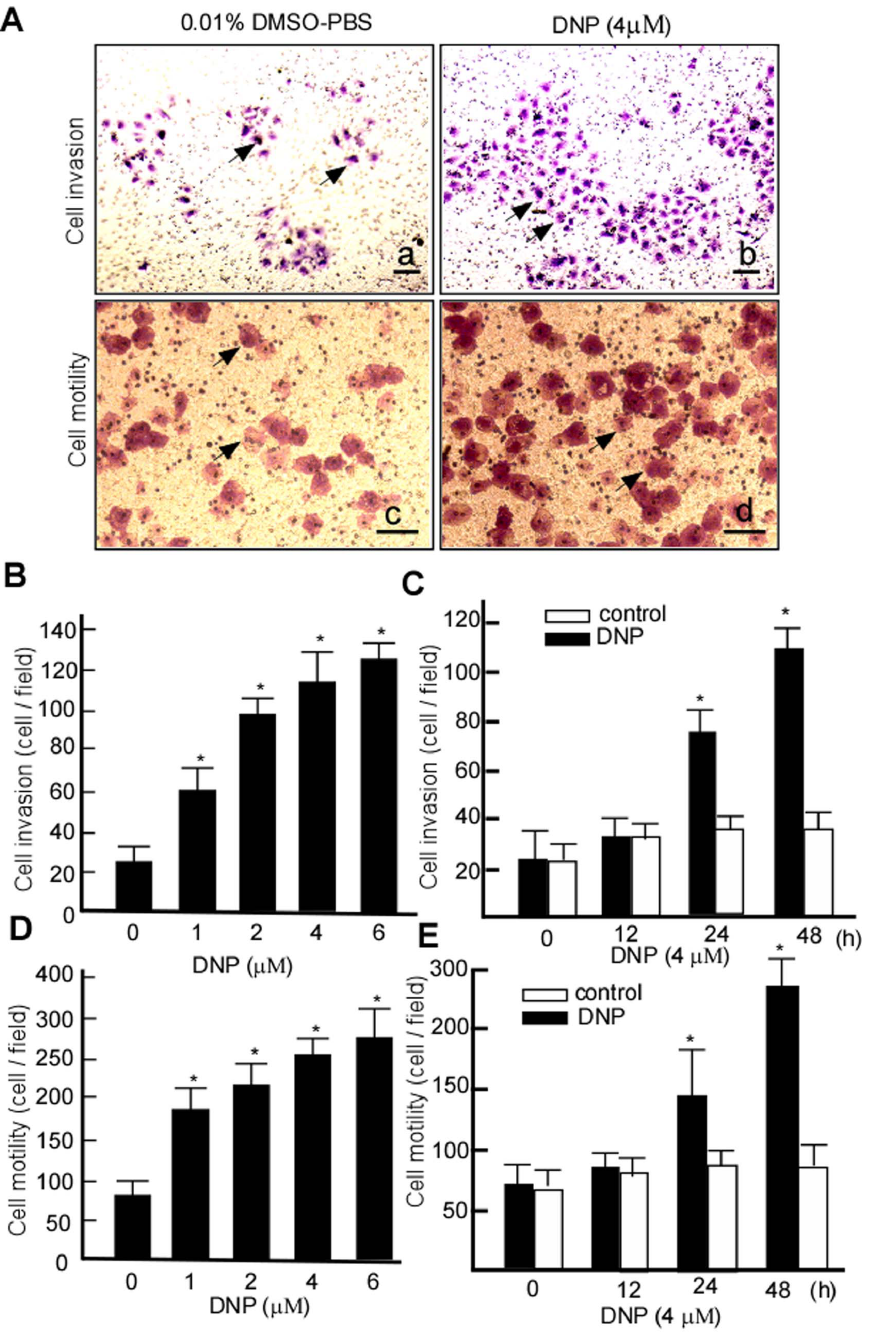
Figure 4. DNP-mediated NPC cell metastasis invitro . A, Matrigel-coated Boyden chambers was used to measure 6-10B cell invasion, and an uncoated Boyden chamber was used to determine cell motility after DNP treatment. The cells invaded to the lower surface of the membrane were fixed with methanol and stained with hematoxylin and eosin. a and c, 6-10B cells treated with 0.1% DMSO-PBS; b and d, 6-10B cells treated with 4 m M DNP; Scale bar=10 m m. Arrows=invaded cell. In dose-dependency assays, 6-10B cells were treated with the indicated concentrations DNP. In time- course assays, cells were treated with 4 m M DNP for the indicated time. Treated cells were subjected to motility and invasion analysis. Images were taken under a light microscope and random fields of view were counted to determine the number of invading cells. B, Invasion of 6-10B cells at various concentrations; C, Invasion of 6-10B cells at various time points; D, Motility of 6-10B cells at various concentrations; and E, Motility of 6-10B cells at various time points. Statistically analysis performed using a one-way analysis of variance (ANOVA) with Dunnett’s post-hoc test (*, p , 0.05). doi:10.1371/journal.pone.0062908.g004 RNA, the HSP70-2 RNA was quantified in 6-10B and CNE2 cells panel), and similar results were obtained in CNE2 cells (Fig. 3A, treated with DNP by using RT-PCR. Following DNP treatment, lane 1 vs. 2, middle panel). DNP-induced HSP70-2 RNA HSP70-2 RNA expression increased (Fig. 3A, lane 1 vs. 2 upper transcription was further validated using real-time PCR. HSP70-